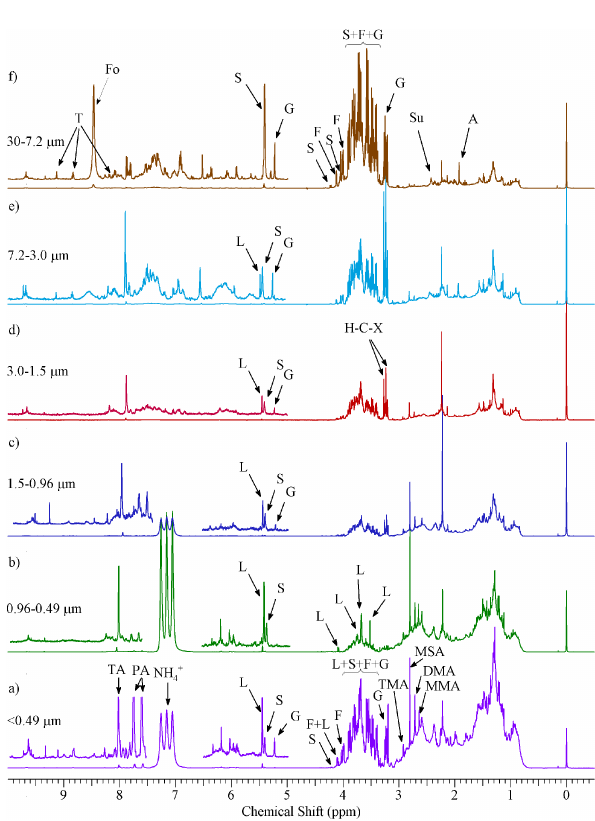
Figure 2. 500 MHz 1H-NMR of size-fractionated WSOC. The seg- ment from δ 4.5 to δ 5.0ppm was removed from all NMR spectra due to H 2 O residues. The peaks were assigned to specific com- pounds as follows: formate (Fo), levoglucosan (L), glucose (G), su- crose (S), methanesulfonate (MSA), trimethylamine (TMA), succi- nate (Su), acetate (A), dimethylamine (DMA), monomethylamine (MMA), fructose (F), trigonelline (T), phthalic acid (PA), tereph- ) thalic acid (TA), ammonium ions (NH + 4